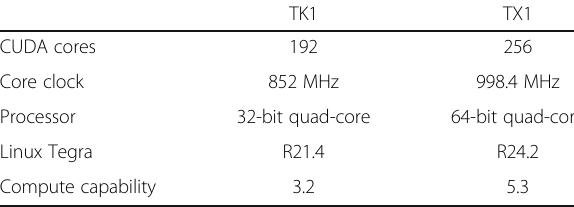
Table 2 Specifications of Jetson